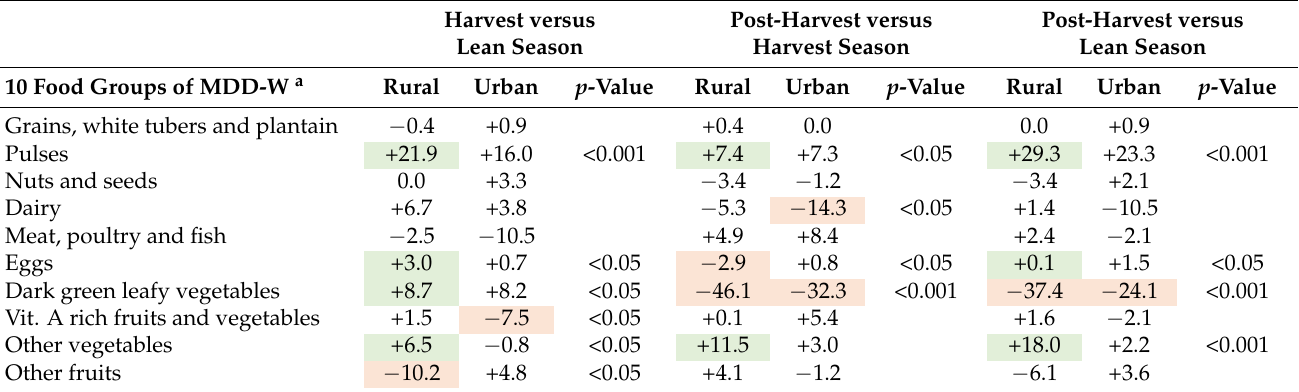
Table 2. Changes in proportions of women (%) eating foods from the ten food groups counted in the women’s dietary diversity scores over time in rural and urban areas in the Kapchorwa District,